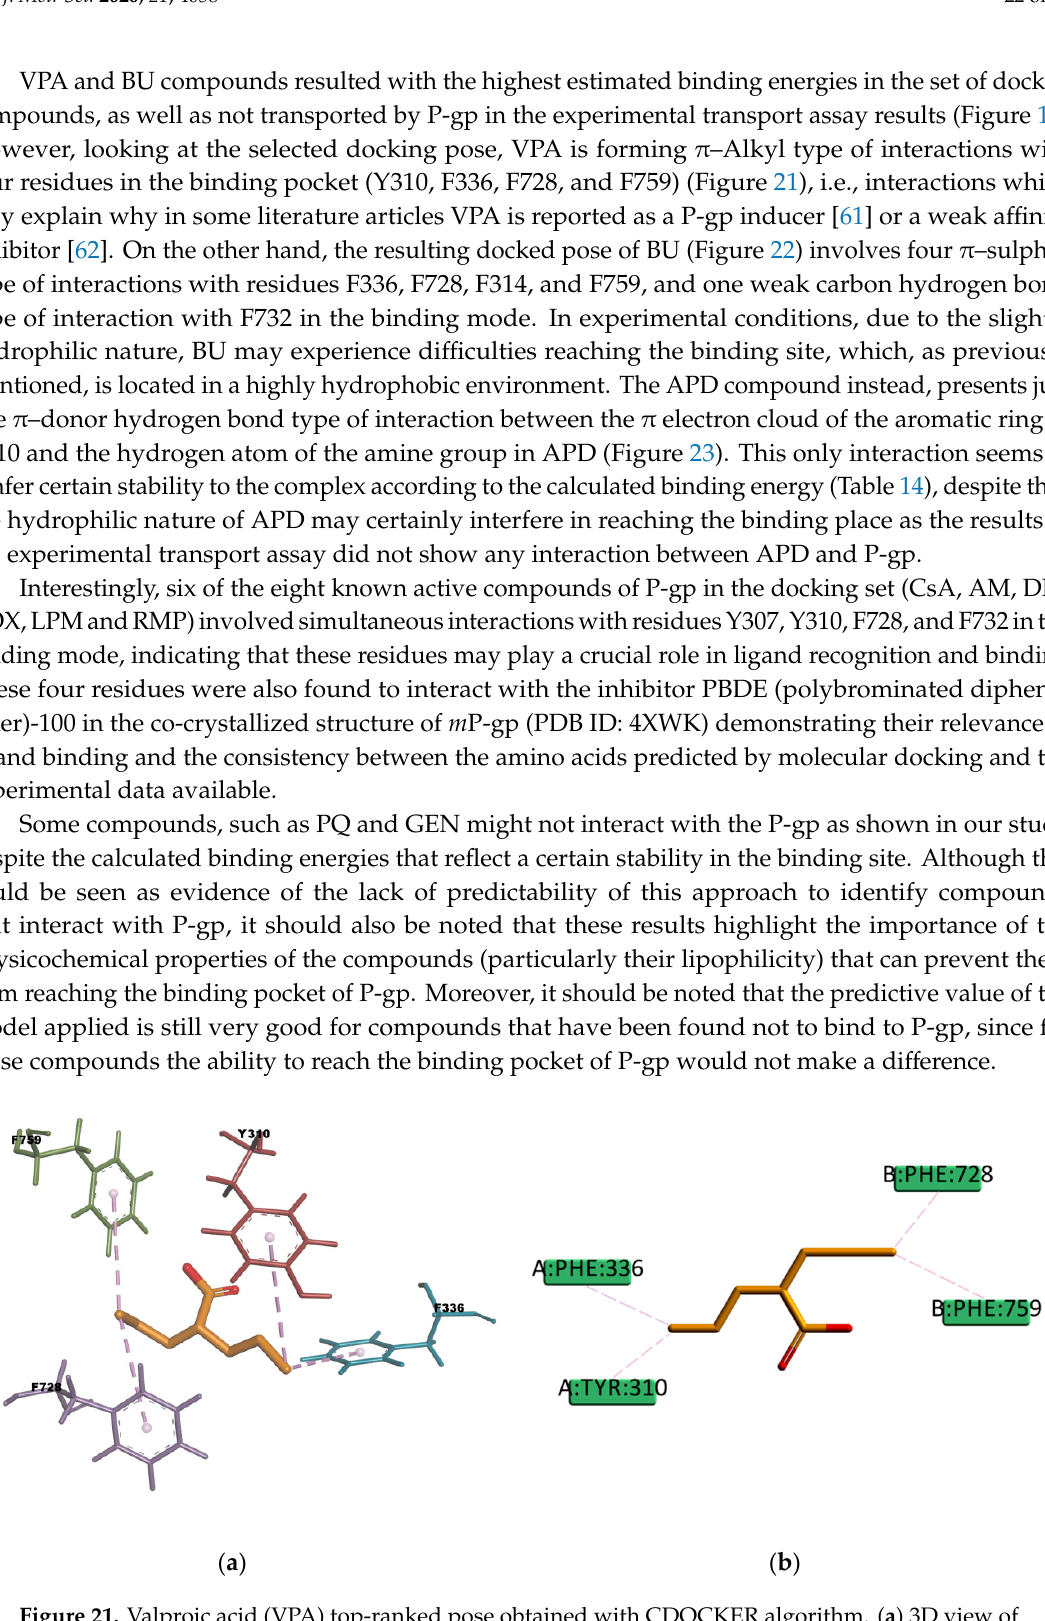
Figure 21. Valproic acid (VPA) top-ranked pose obtained with CDOCKER algorithm. ( a ) 3D view of VPA interactions in the binding pocket. Light-rose dotted lines represent hydrophobic interactions; ( b ) 2D interaction diagram of VPA with h P-gp interacting residues. Light-rose dotted lines represent hydrophobic interactions.